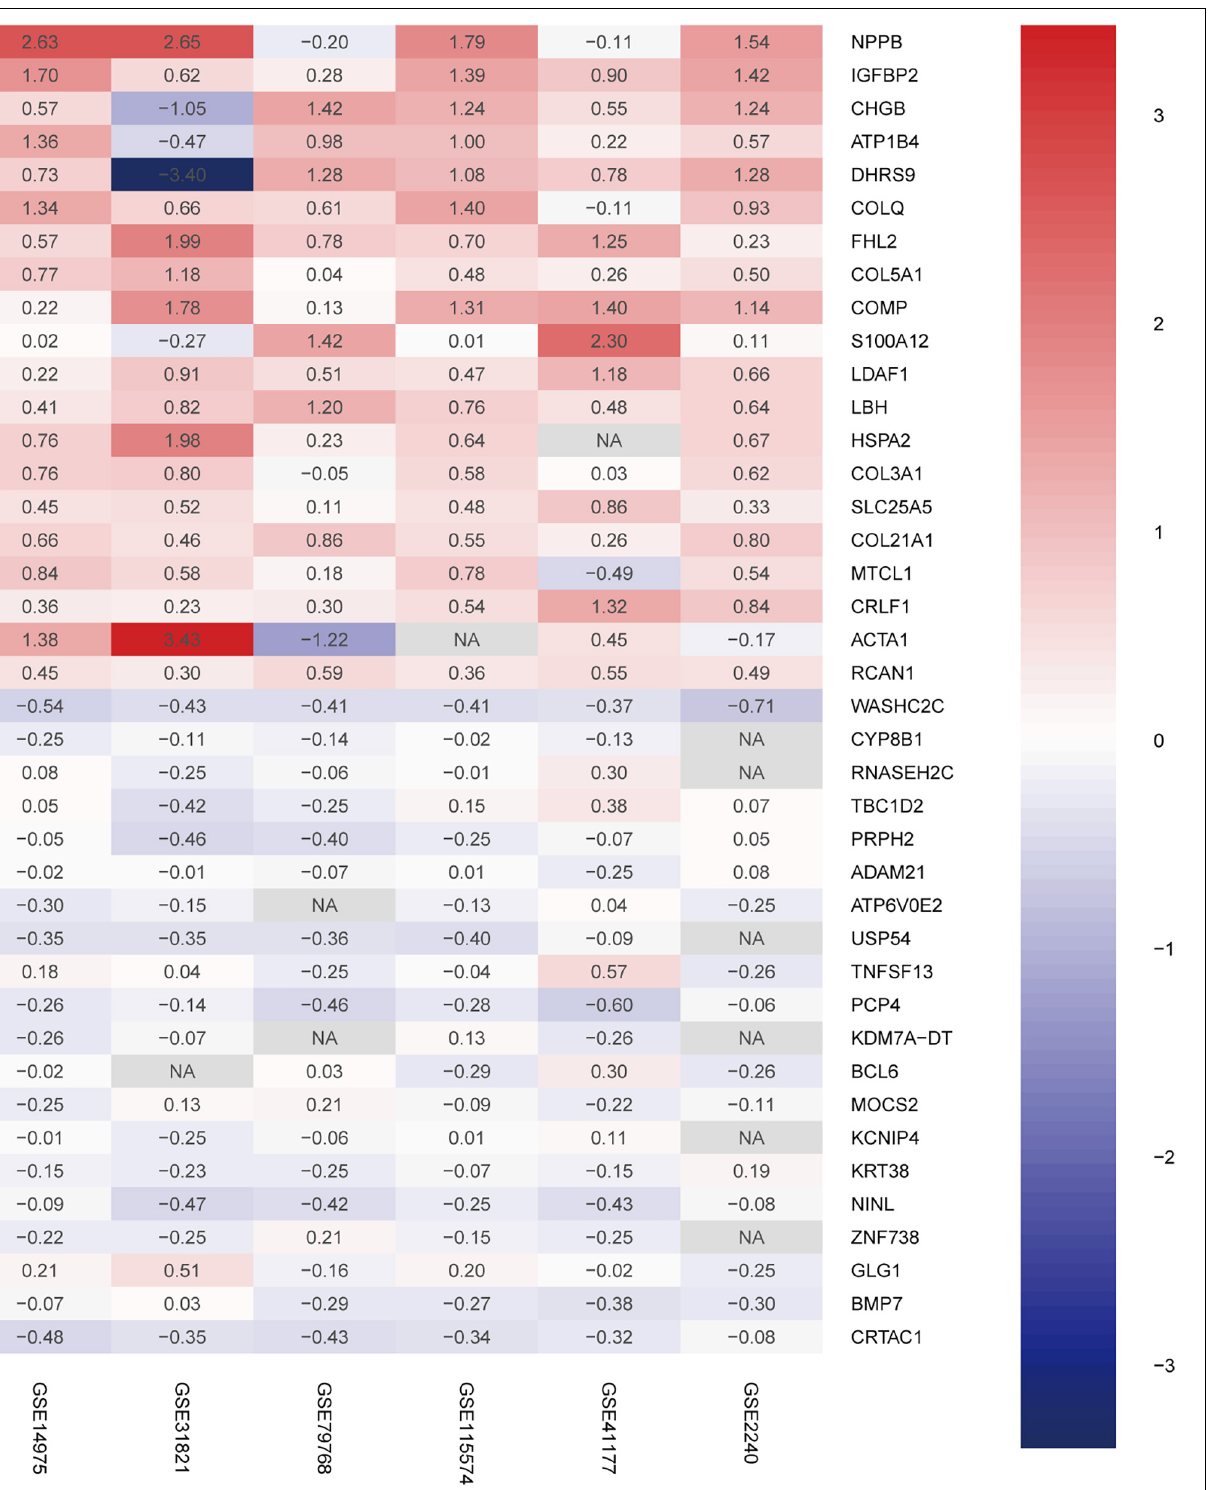
FIGURE 2 | Robust DEGs identified by RRA analysis. Heatmap of the six datasets showing the top 20 upregulated and 20 downregulated DEGs. The horizontal axis indicates the gene name, and the vertical axis represents dataset name. Red indicates that the gene is upregulated in the AF patients compared with the SR individuals, and the blue represents downregulation. The number in a cell indicates the logFC of each gene in a dataset. DEG, differentially expressed gene; RRA, robust rank aggregation.